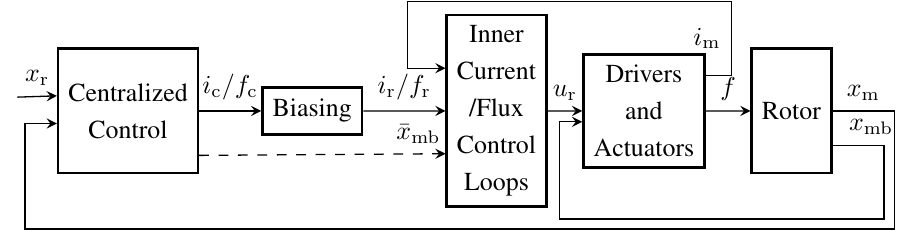
Figure 2. Cascaded control diagrams. For current (flux)-controlled AMB, the centralized controller provides a vector of four control currents, iii (forces fff ), and after biasing the c c vector of eight reference currents, iii (forces fff ), to the inner control loops. Additionally, the r r inner flux loops require the vector of estimated rotor displacements in bearing planes xxx . mb xxx , iii , uuu , fff and xxx are vectors of reference positions, measured currents, reference voltages, r m r m and bearing force rotor displacements in sensor planes,